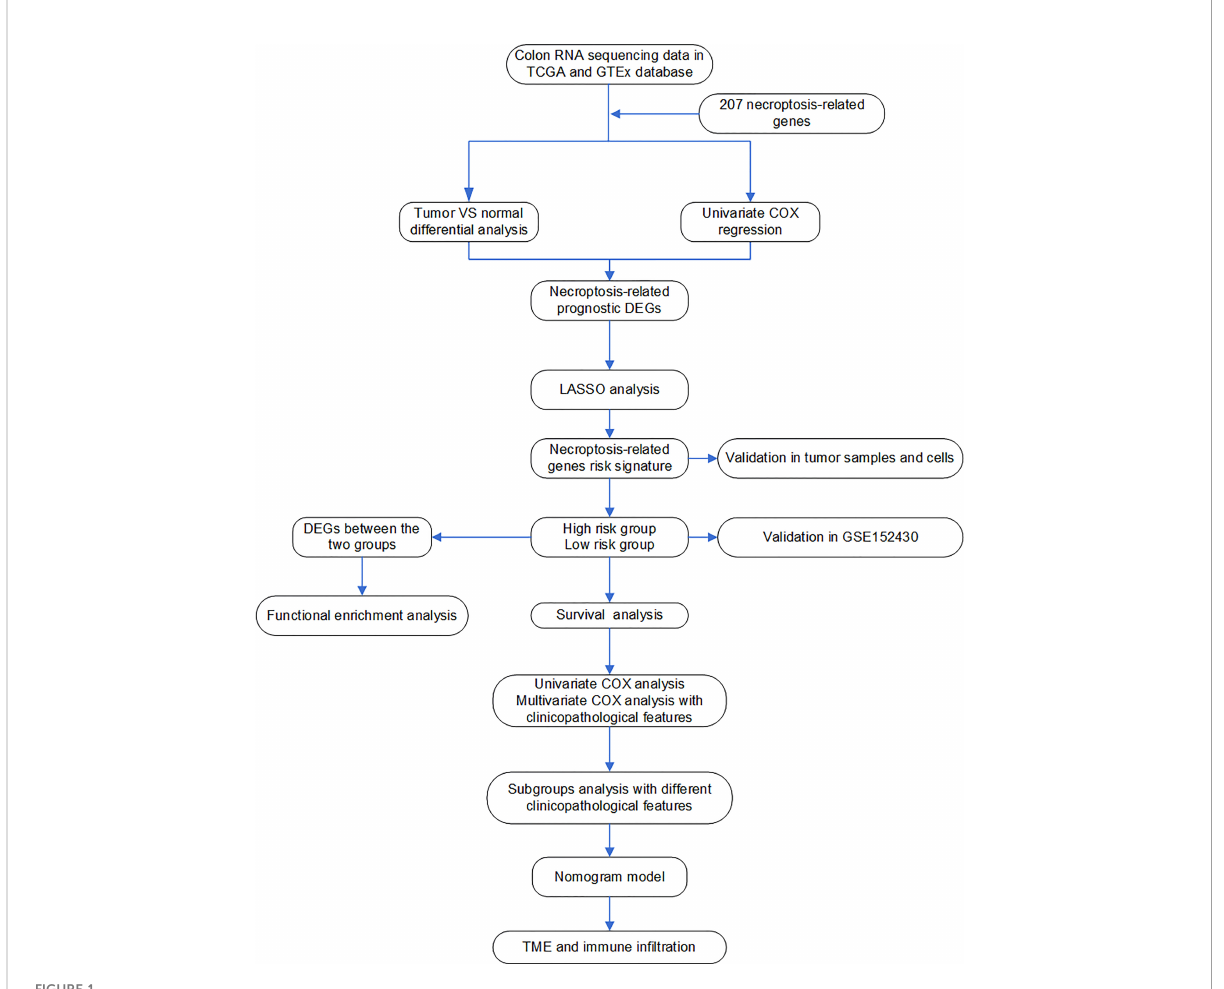
FIGURE 1 Flow chart of the analyses used in this